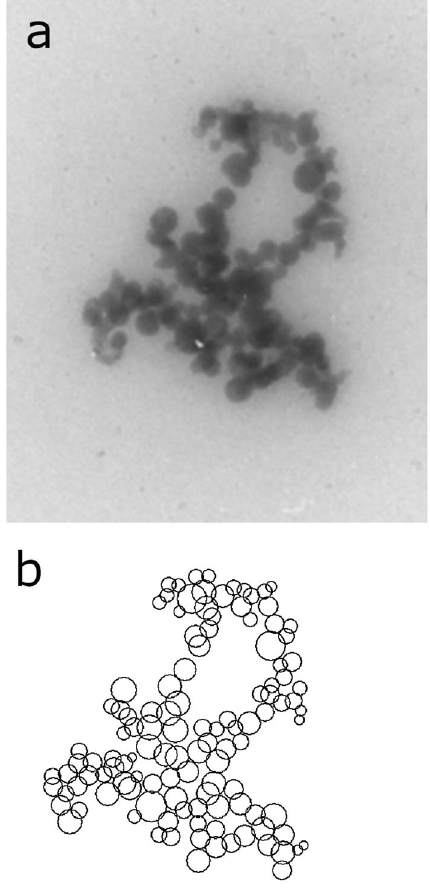
Fig. 4 Example of TEM image of aerosol aggregate sampled in the coal mine ( a ), and its approximation by spheres ( b )